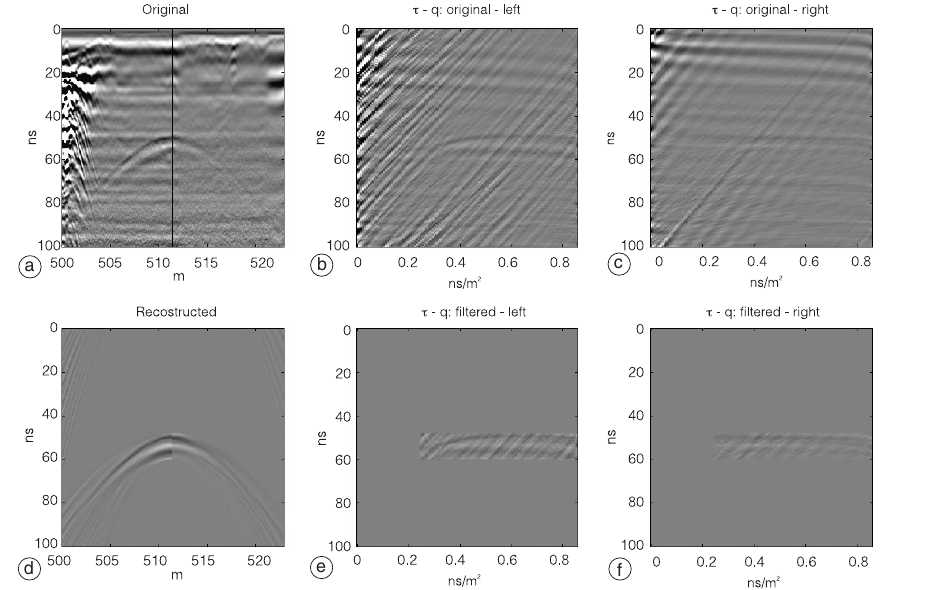
Fig. 7a-f. Example 3: surface-scattering removal by means of the parabolic Radon transform ( t -q